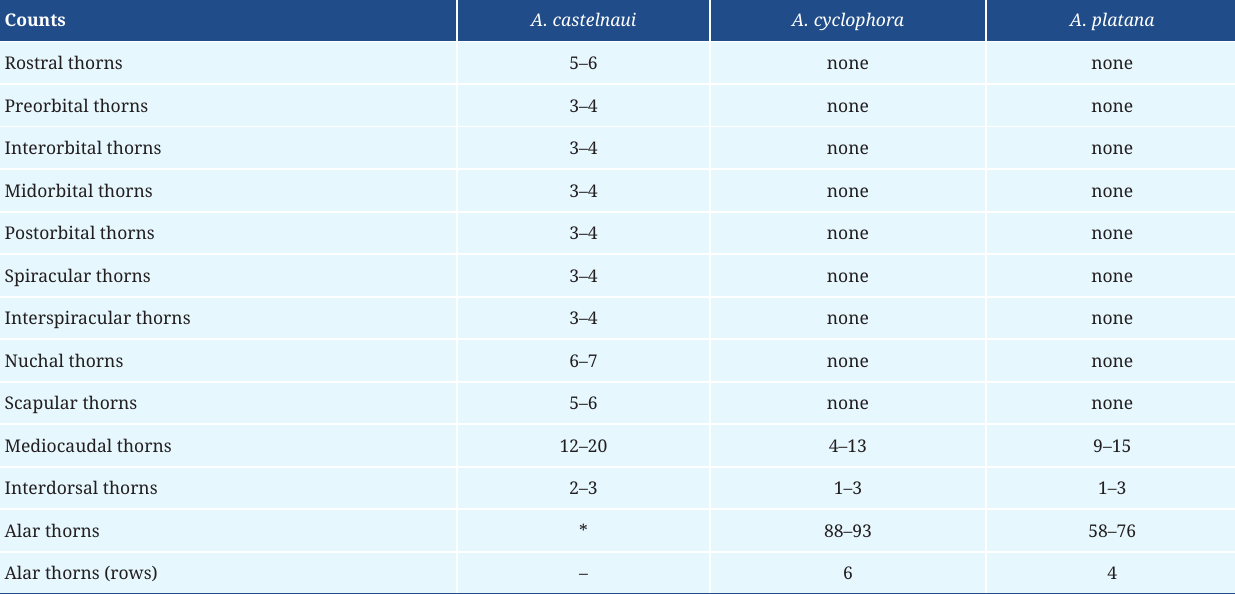
TABLE 2 | Counts of thorns in Atlantoraja species. *No adult males of A. castelnaui were examined.